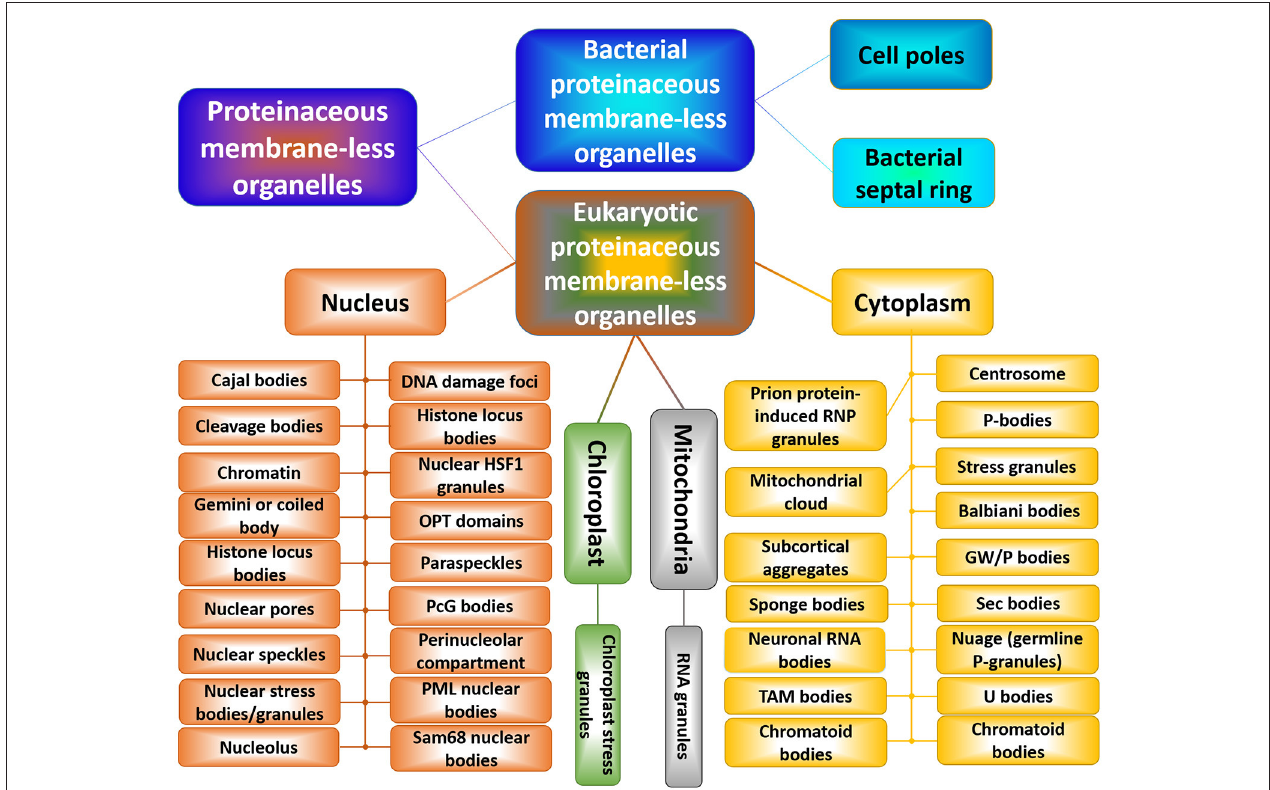
FIGURE 5 | Schematic representation of the horde of cytoplasmic, nuclear, mitochondrial, and chloroplast PMLOs in eukaryotes and bacterial PMLOs. This figure was adopted with permission from Zaslavsky and Uversky [ 203].